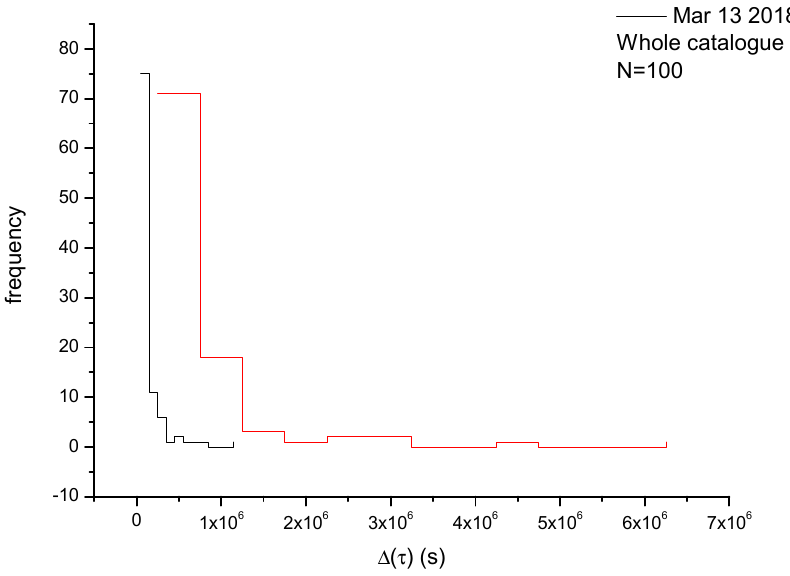
Figure 3. Comparison between frequency of Δ τ in two different windows corresponding to maximum (red) and minimum (black) SE for the whole catalogue with a moving window of length N = 100.